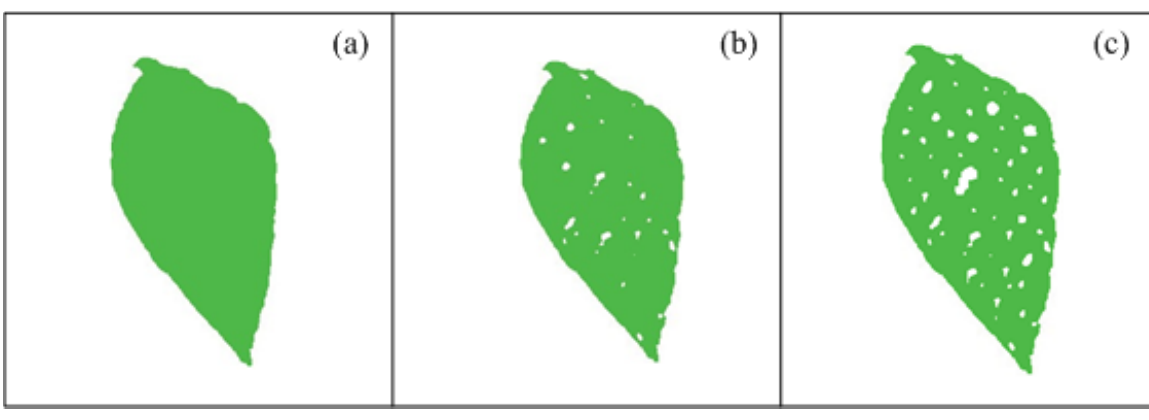
density of white-spot symptom. ( c ) Unhealthy bean leaf with high density of